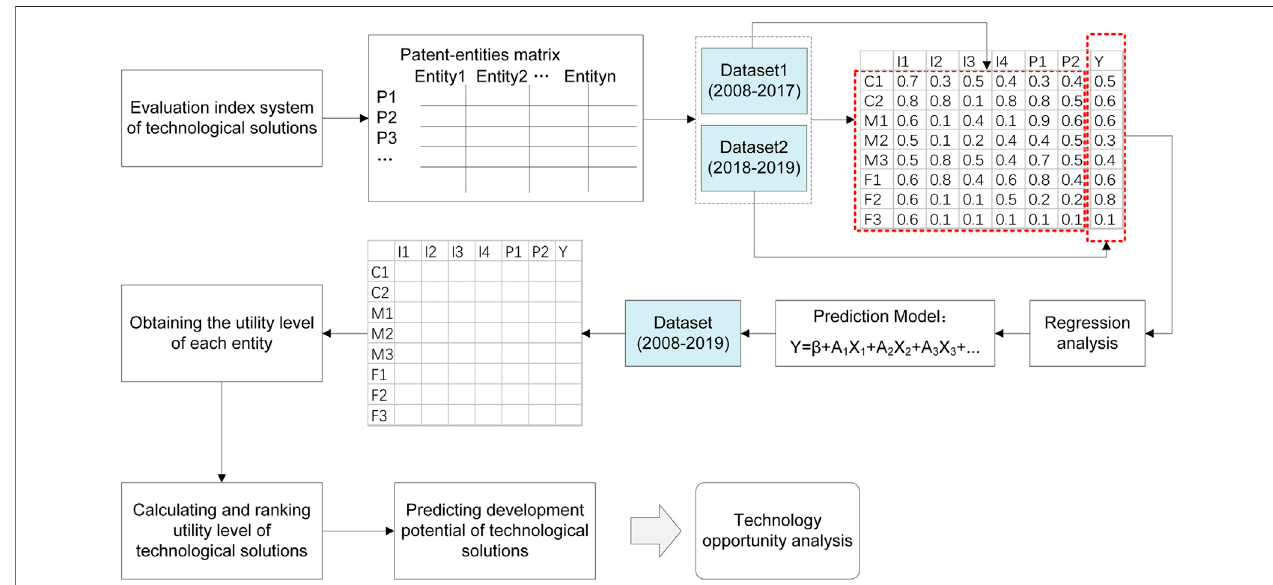
FIGURE 6 | Establishing and verifying technology prediction